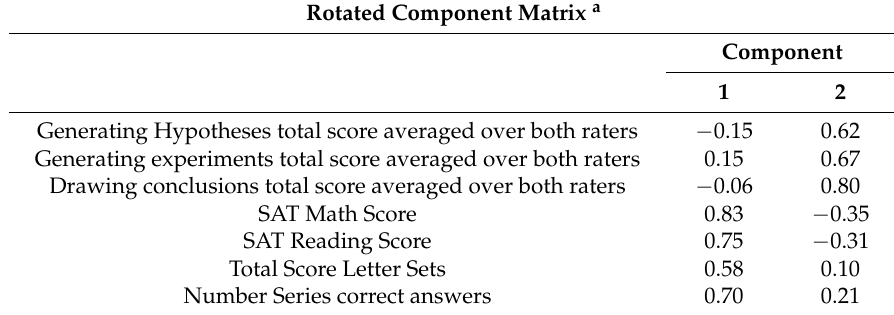
Table 7. Rotated principal component matrix in the Study 1 analysis of the total scores of our subscales, the analytical ability tests, and SAT